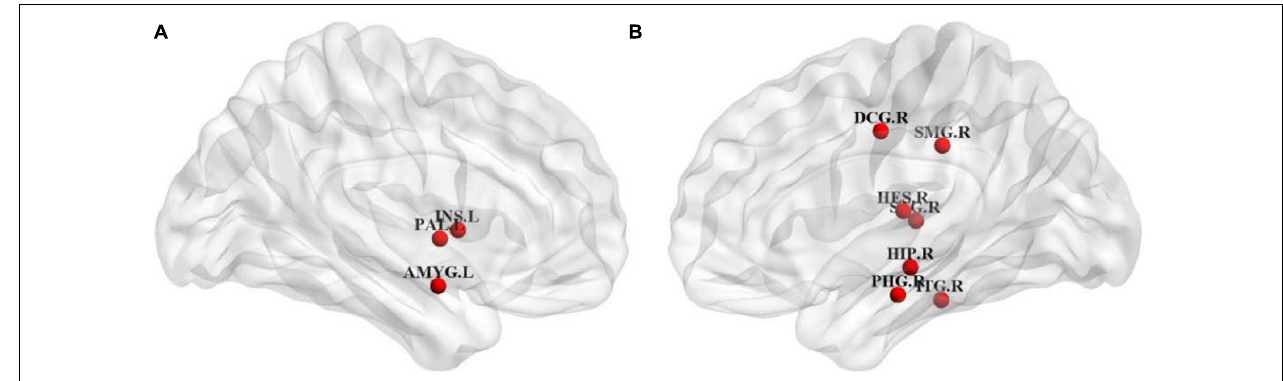
FIGURE 5 | Distribution diagram of discriminative brain regions. (A) Coronal view of left hemisphere. (B) Coronal view of right